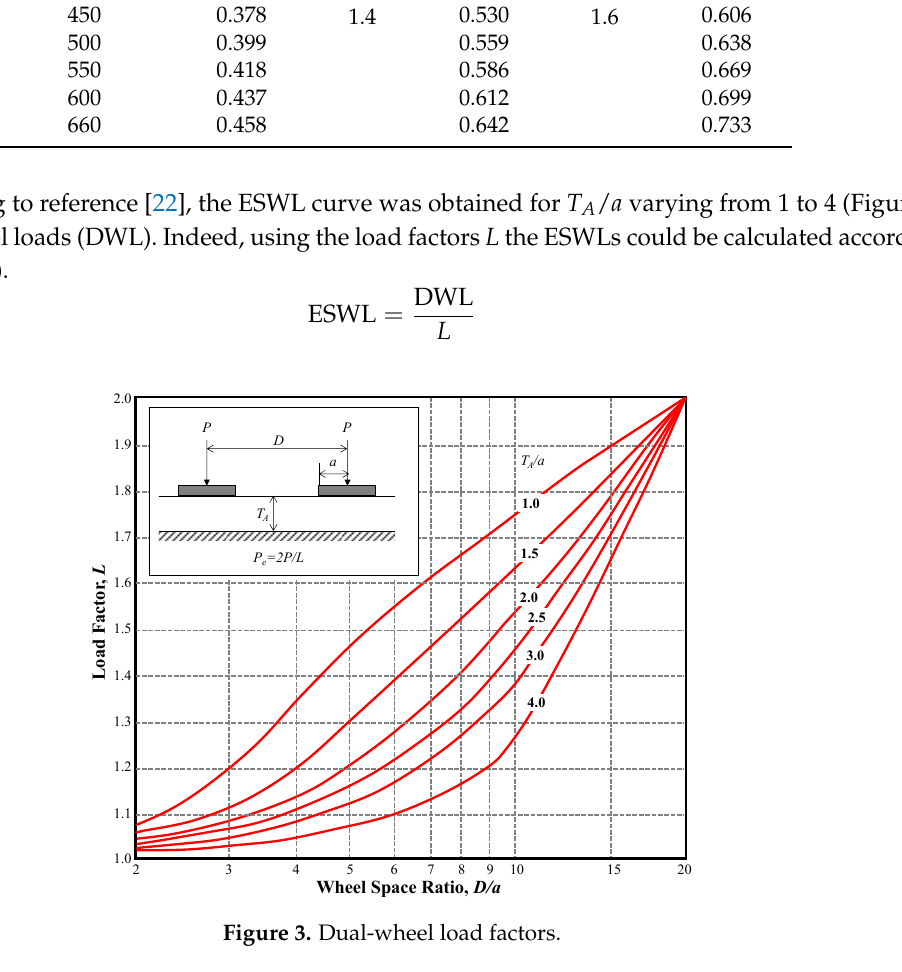
Table 4. Data to draw the ESWL curve.